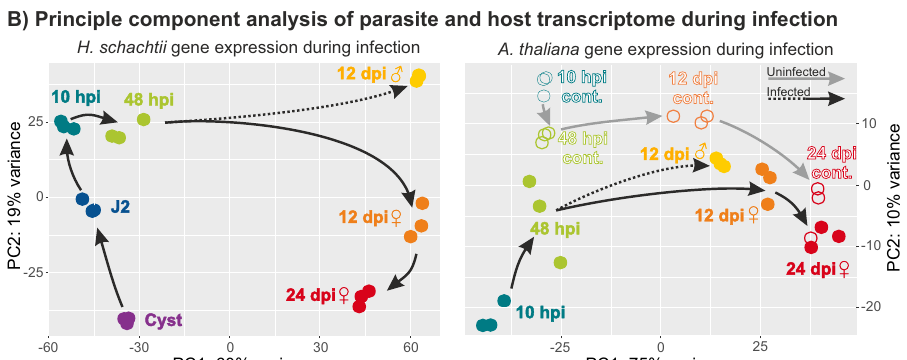
proportion of reads mapping to either parasite or host in parentheses. B Principle components 1 and 2 for H. schachtii and A. thaliana expression data are plotted. Arrows indicate progression through the life cycle/real-time. Hours post infection (hpi), days post infection